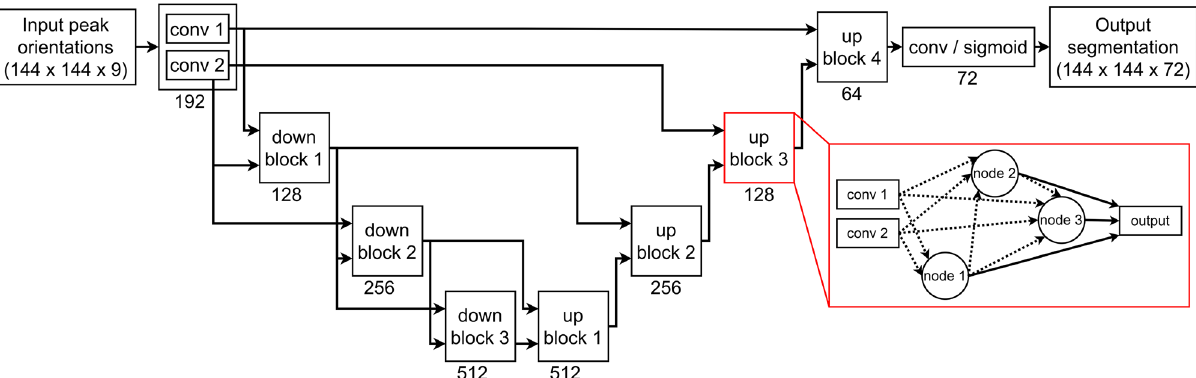
Figure 1. Architecture diagram for the macro-architecture that remains fixed during NAS. The numbers under blocks indicate the number of filters used by each convolution-based operation within the block. The fixed convolution operations in the first block called ’conv 1’ and ’conv 2’ are 1 × 1 stride 1, and 3 × 3 stride 2 convolutions respectively. An example of the inside of a block is highlighted in red. Each block contains two fixed 1 × 1 convolution operations, and 3 nodes each consisting of 2 basic operations. All convolution-based operations within a node will be 3 × 3 with ’same’ padding. The dotted arrows indicate possible